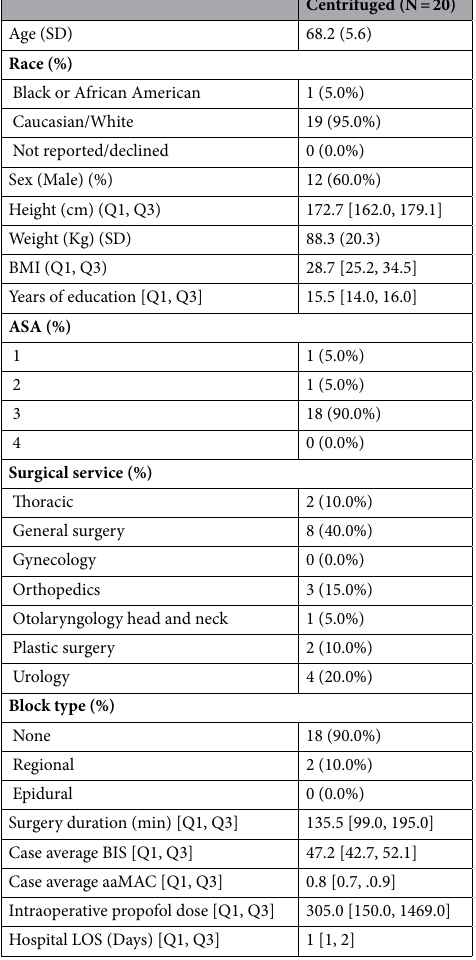
Table 2. Patient characteristics for centrifuged samples. Average bispectral index (BIS) values were calculated from all 20 patients in the centrifuged samples group. Case average age-adjusted minimum alveolar concentration (aaMAC) was calculated for those patients who received an inhaled anesthetic for more than half of the case; N = 11 patients in the centrifuged samples group. American Society of Anaesthesiologists scores (ASA) are presented as percentages of non-centrifuged patient samples and centrifuged patient samples. Hospital length of stay (LOS) values are listed in